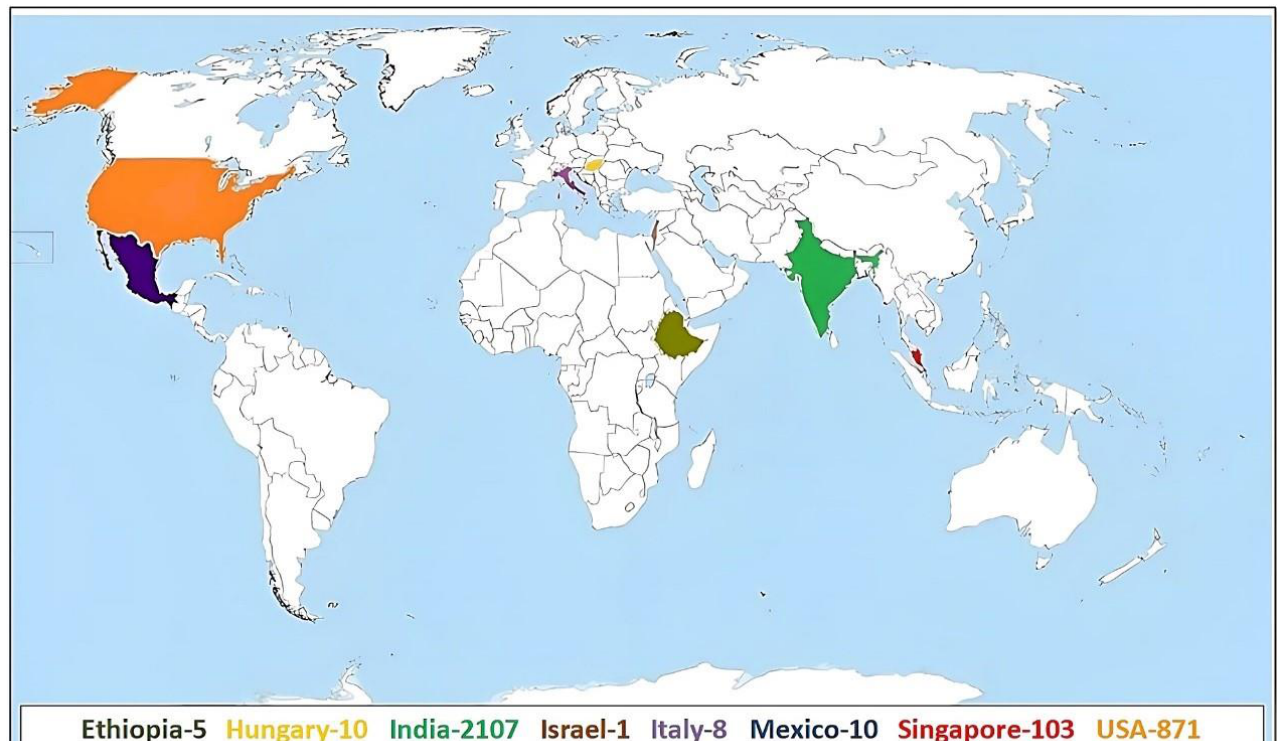
Figure 1. Details of the sources and number of safflower accessions used in the study. Table 2. SSR Primers and sequence